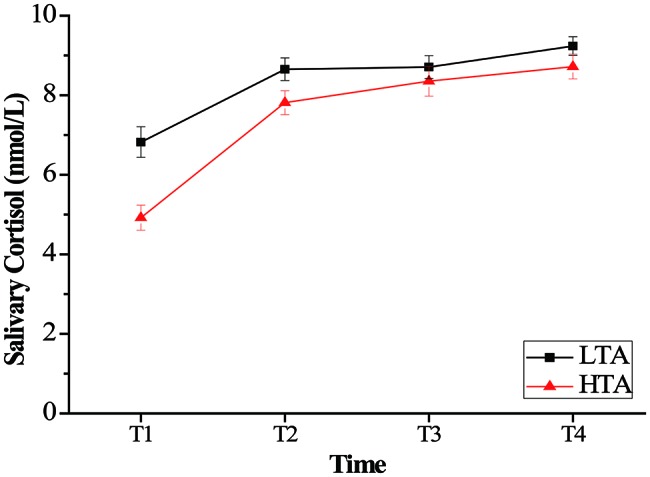
Mean salivary alpha amylase (U/ml) as a function of time (minutes following intervention onset) for the stress. Error bars represent standard errors of the means.